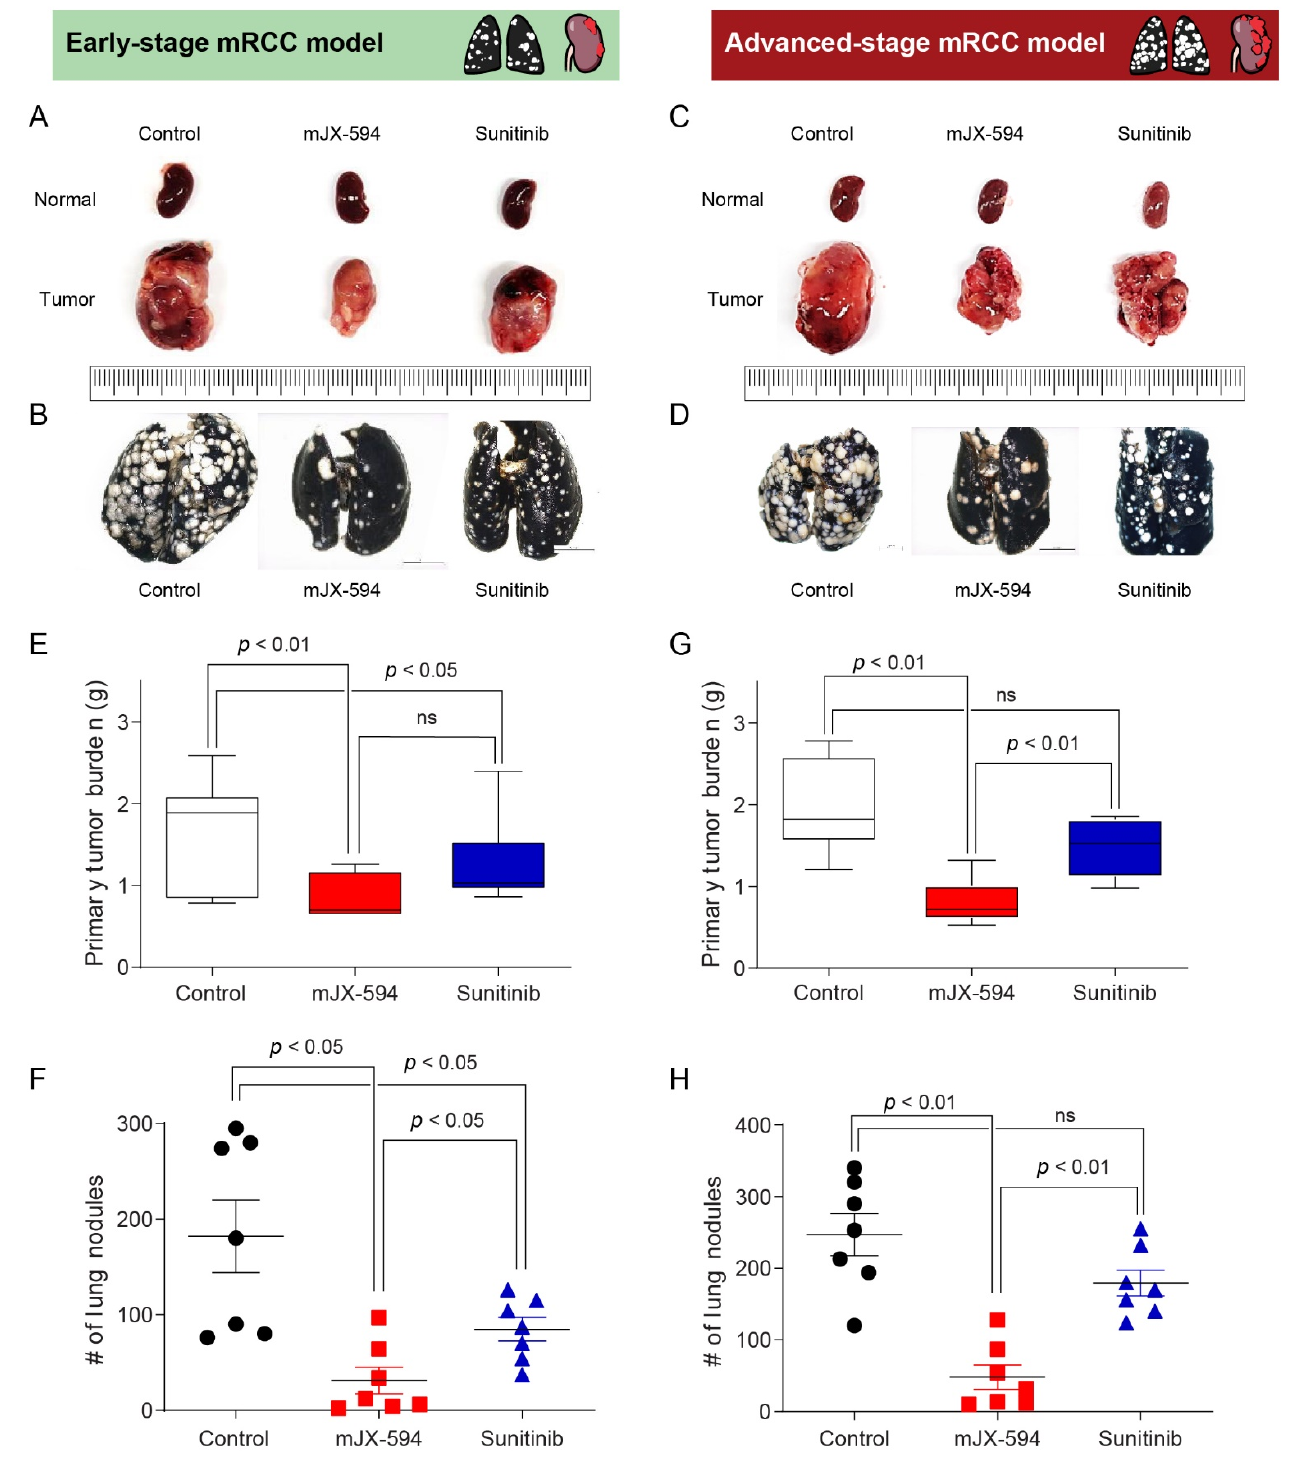
Figure 3. Representative images and comparisons of primary tumor burden and number of lung nodules in mJX-594-treated, sunitinib-treated, and control (PBS-treated) mice. ( A ) Comparison of primary tumor burden after the treatments in early-stage metastatic renal cell carcinoma (mRCC) model. ( B ) Comparison of lung metastasis after the treatments in early-stage mRCC model. ( C ) Comparison of primary tumor burden after the treatments in advanced-stage mRCC model. ( D ) Comparison of lung metastasis after the treatments in advanced-stage mRCC model. Therapeutic efficacy of mJX-594 and sunitinib treatment in early- and advanced-stage mRCC models. ( E ) Comparison of primary tumor burden after the treatments with mJX-594, sunitinib, or control (PBS)